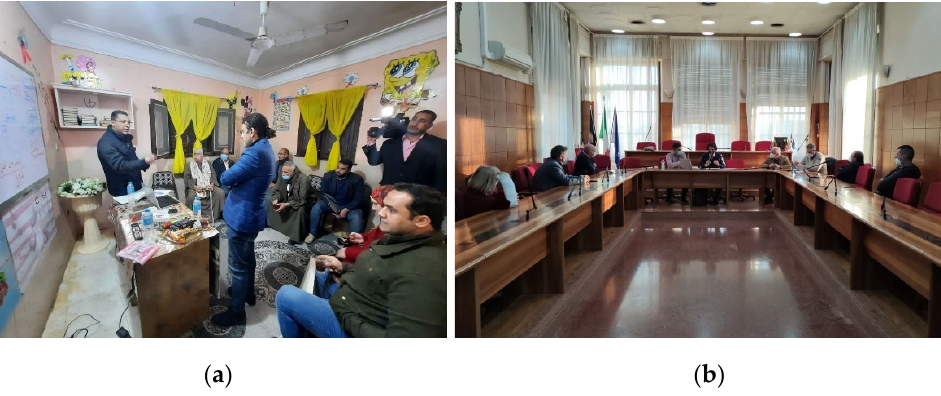
Figure 12. ( a ) Discussion between the first author and the participants in Lasiafar Albalad, hosted by Al ‐ Bakyat Al ‐ Salihat Ngo (image taken by Amira Gaweesh from the NGO); ( b ) Discussion between the first author and the focus group in Pontinia (image taken by Simone Coco from Pontinia Municipality).